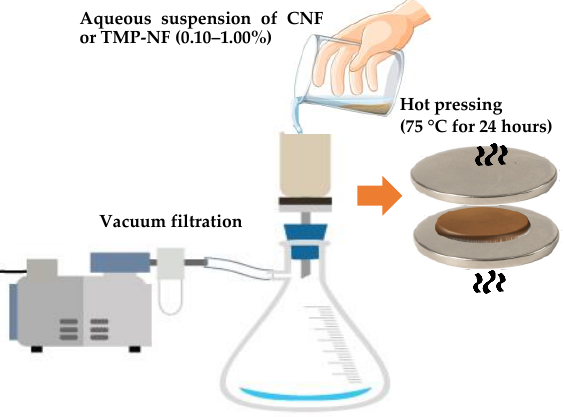
Figure 2. Scheme for the development of CNF and TMP-NF films.